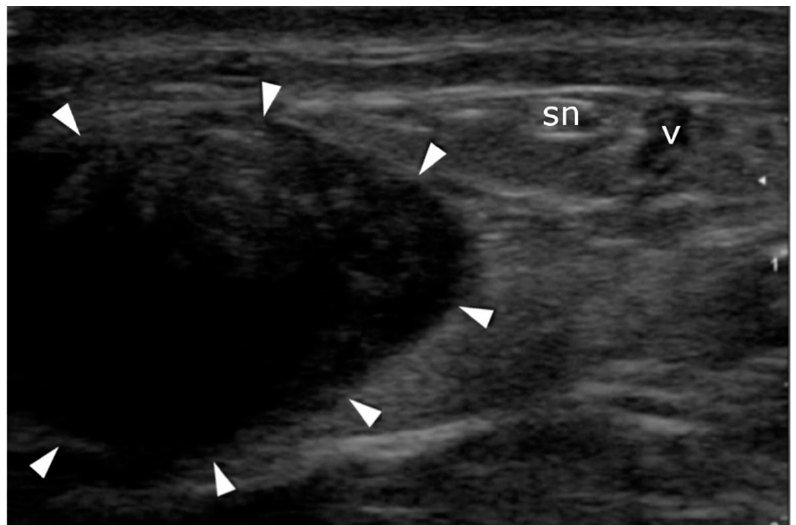
Figure 5. Sural nerve identification: transverse plane. The nerve (sn) and vein (v) pass on the lateral side of the Achilles tendon (arrowheads).